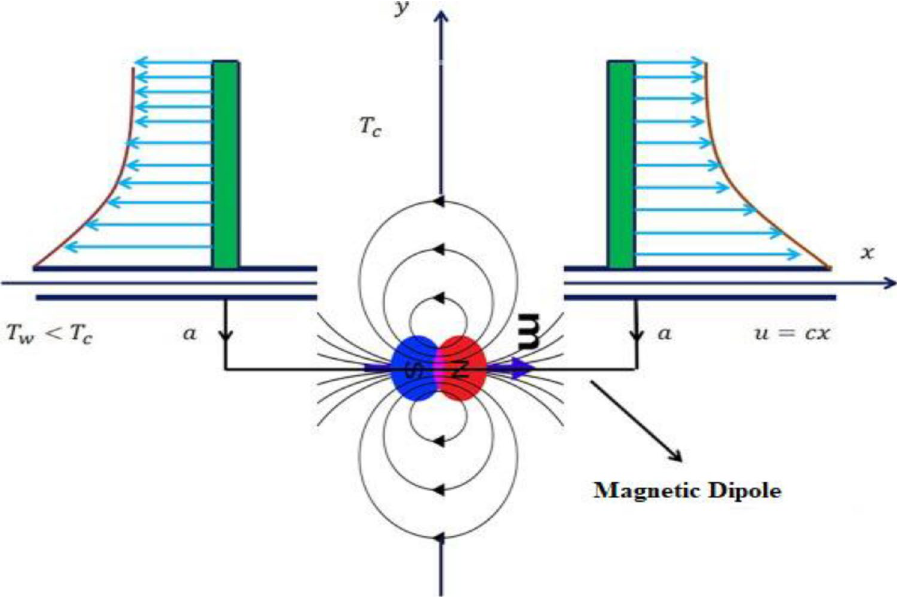
Figure 1. Schematic flow